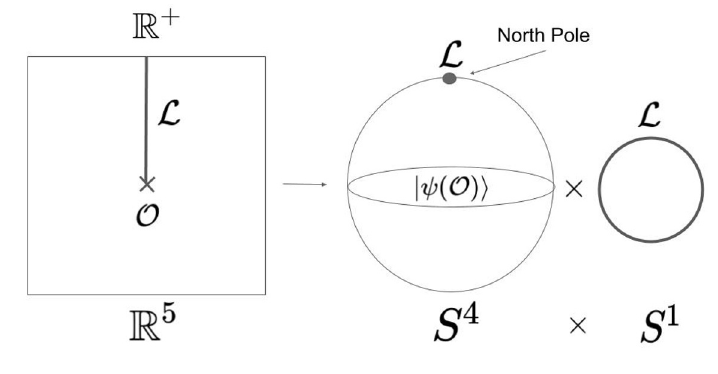
Figure 1 . Left: theory on R 5 with a line defect L stretched along R + ending at the origin of R 5 with a local junction operator O sitting at the end point. Right: theory on S 4 × S 1 with L wrapping S 1 and sitting at the north pole of S 4 . The system on the left is related to the system on the right by a conformal transformation, with the local junction operator O being mapped to a state | ψ ( O ) i on S 4 (with L sitting at the north